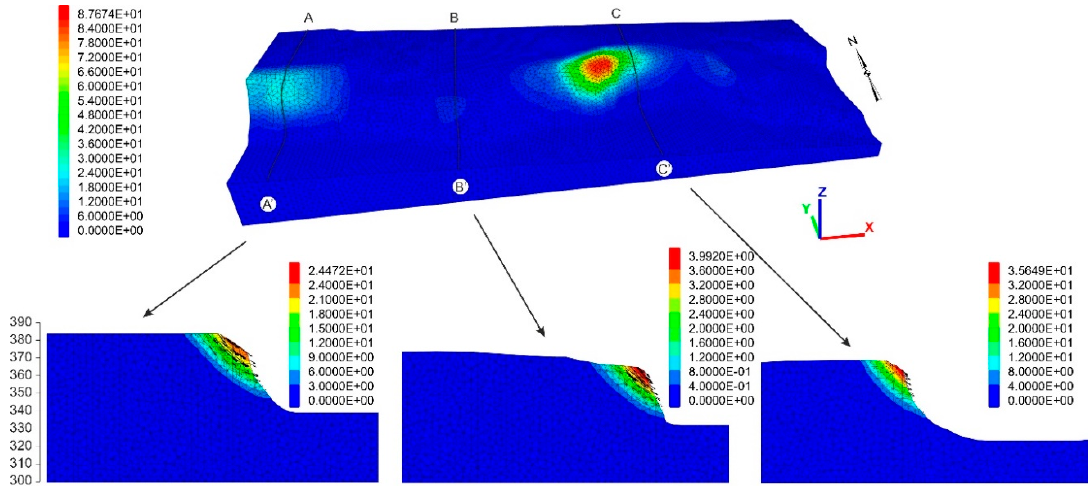
Figure 18. Contour 3D displacements and displacement vectors (sections) of the pre-landslide model without discontinuities.